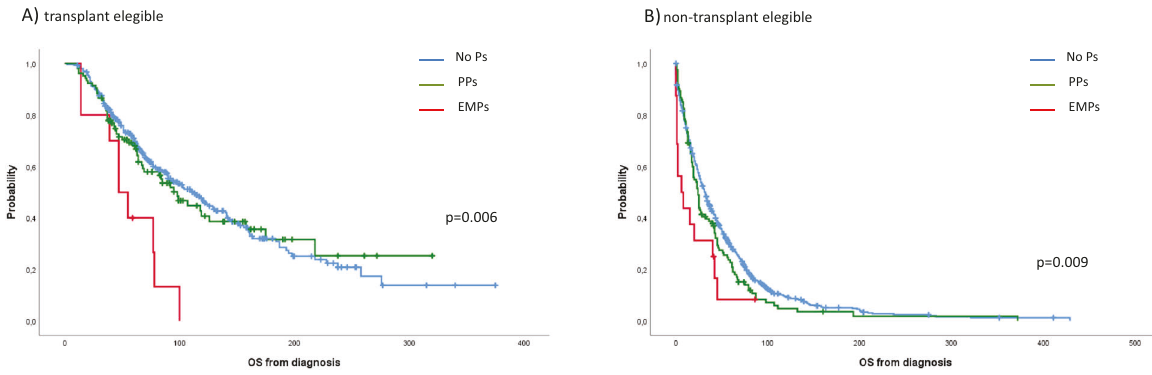
Fig. 2 Overall survival from diagnosis. A In transplant eligible and B non-transplant eligible fi rst relapse was similar (14.6%) to that observed at diagnosis while the incidence of EMPs signi fi cantly increased at relapse (from 1.9% (Table 2). Of interest, the incidence of plasmacytomas at fi rst relapse in patients with and without plasmacytomas at diagnosis was 46% versus 13%, respectively ( p < 0.00001). The incidence of plamacy- tomas at relapse in patients who underwent up-front ASCT vs. those who did not was 22% vs 17.8% ( p = 0.22). No differences in the incidence of plasmacytomas were observed between patients initially treated with chemotherapy or new drugs (18.6% vs 19.4%, p = 0.37). Fifty six percent of patients relapsing with plasmacytomas had involvement in two or more locations. The location of PPs were similar to that observed at diagnosis (paravertebral 50%, chest 45.7%, skull 16.9%, pelvis 11.2%, long bones 6.3%). Regarding EMPs, we observed an increased incidence of skin involvement (40%),